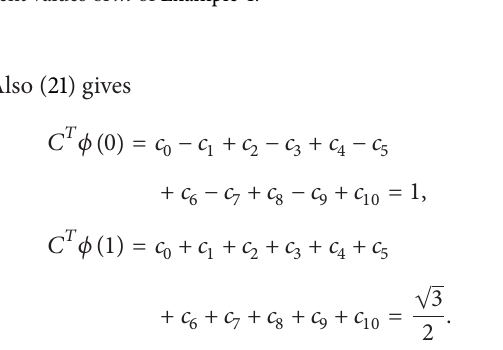
Figure 2: Absolute errors of 𝑢(𝑥) in the interval 𝑥 ∈ [0,1] for different values of 𝑚 of Example